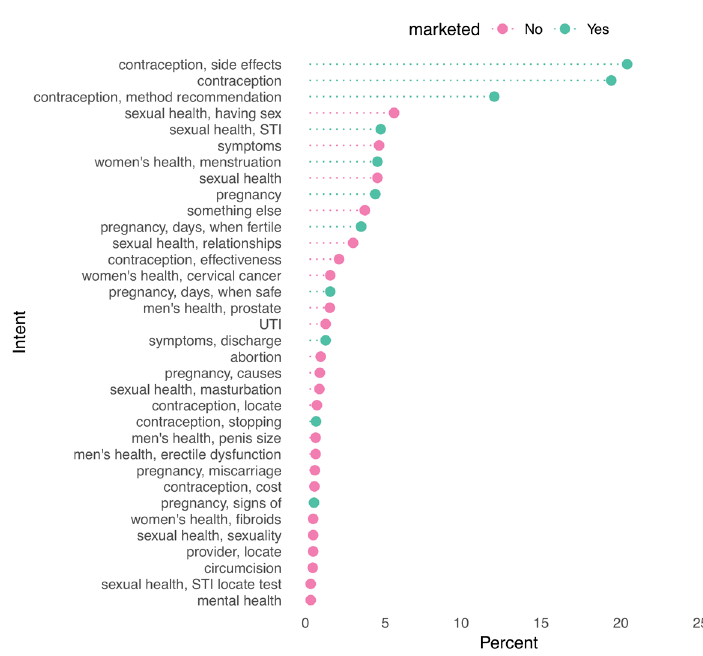
Figure 9. Distribution of classified intents by marketing history. STI, sexually transmitted infection; UTI, urinary tract infection.